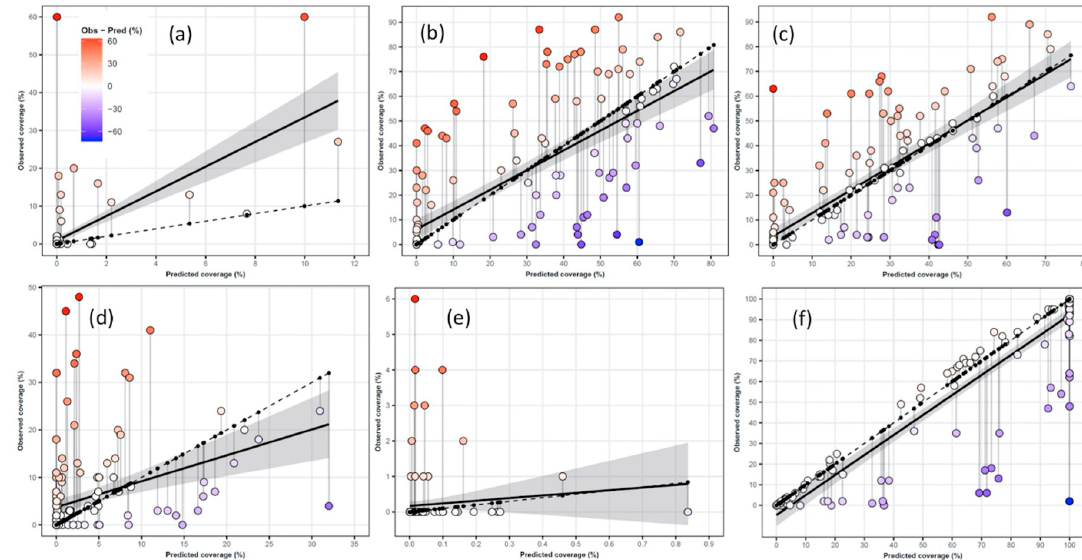
Figure 8. Relationship between observed coverage values (%) from testing data (n = 154) on the y-axis, and corresponding predicted coverage values (%) from biological component models on the x-axis. ( a ) Annual algae, ( b ) perennial algae, ( c ) epibenthic bivalves ( Mytilus spp.), ( d ) cnidarians, ( e ) epibenthic moss animals ( Bryozoans ), ( f ) colonized substrate. The solid black line corresponds to the linear regression and 95% confidence band (grey shade) between observed and predicted coverage. The dashed line corresponds to a theoretical 1:1 line where observed and predicted values are equal (i.e., y = x, y-intercept = 0, slope = 1), black points along this line represent the specific predicted coverage values. Point colors represent the magnitude of difference between an observed value and its corresponding predicted value on the 1:1 line (black point). Table 12. Accuracy of percent coverage biological components (HUB level-5 groups). Accuracy was measured (testing data, observed vs. predicted) with R 2 , root mean square error (RMSE), mean absolute error (MAE) and mean error (ME), in addition, the predicted values were grouped and evaluated with overall accuracy (OA) as classes (0–10%, 10–50%, 50–90%, 90–100%) and absence - presence ( < absence threshold, > absence threshold 100%). R 2